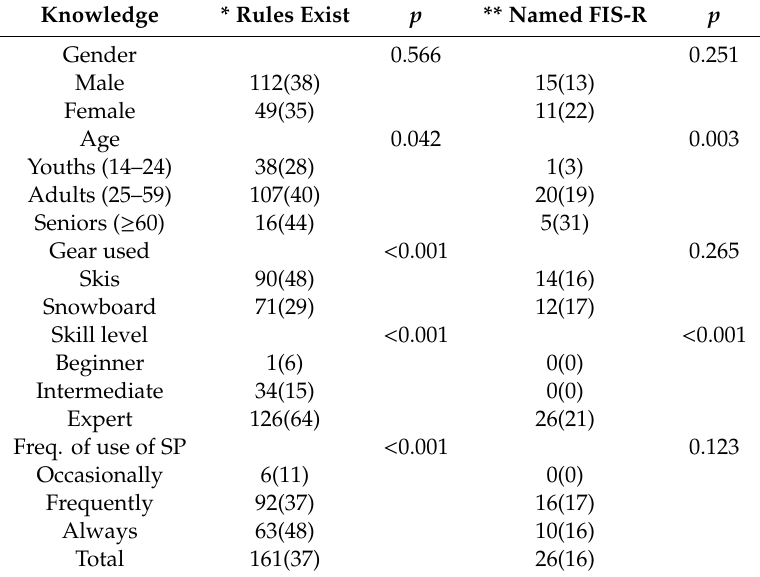
Table 6. General knowledge of FIS Rules for SPs among survey